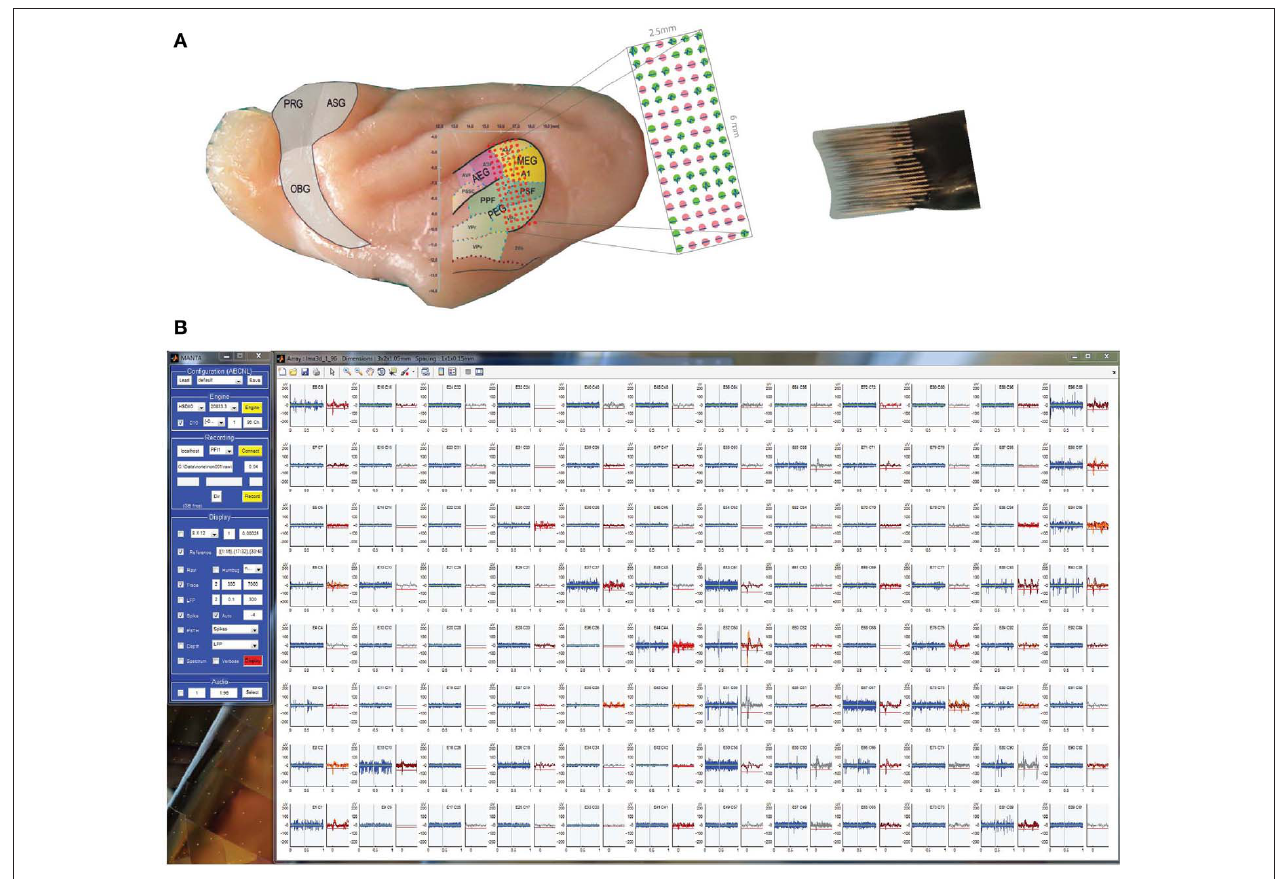
indicated by the channel map superimposed on a generic ferret brain (brain preparation and image courtesy of Dr. Susanne Radtke-Schuller). Locations with spikes at this depth are indicated by a green circle in the magnified representation. (B) Raw data traces for each channel in the array during a pure tone tuning stimulus, with both voltage trace and spike display